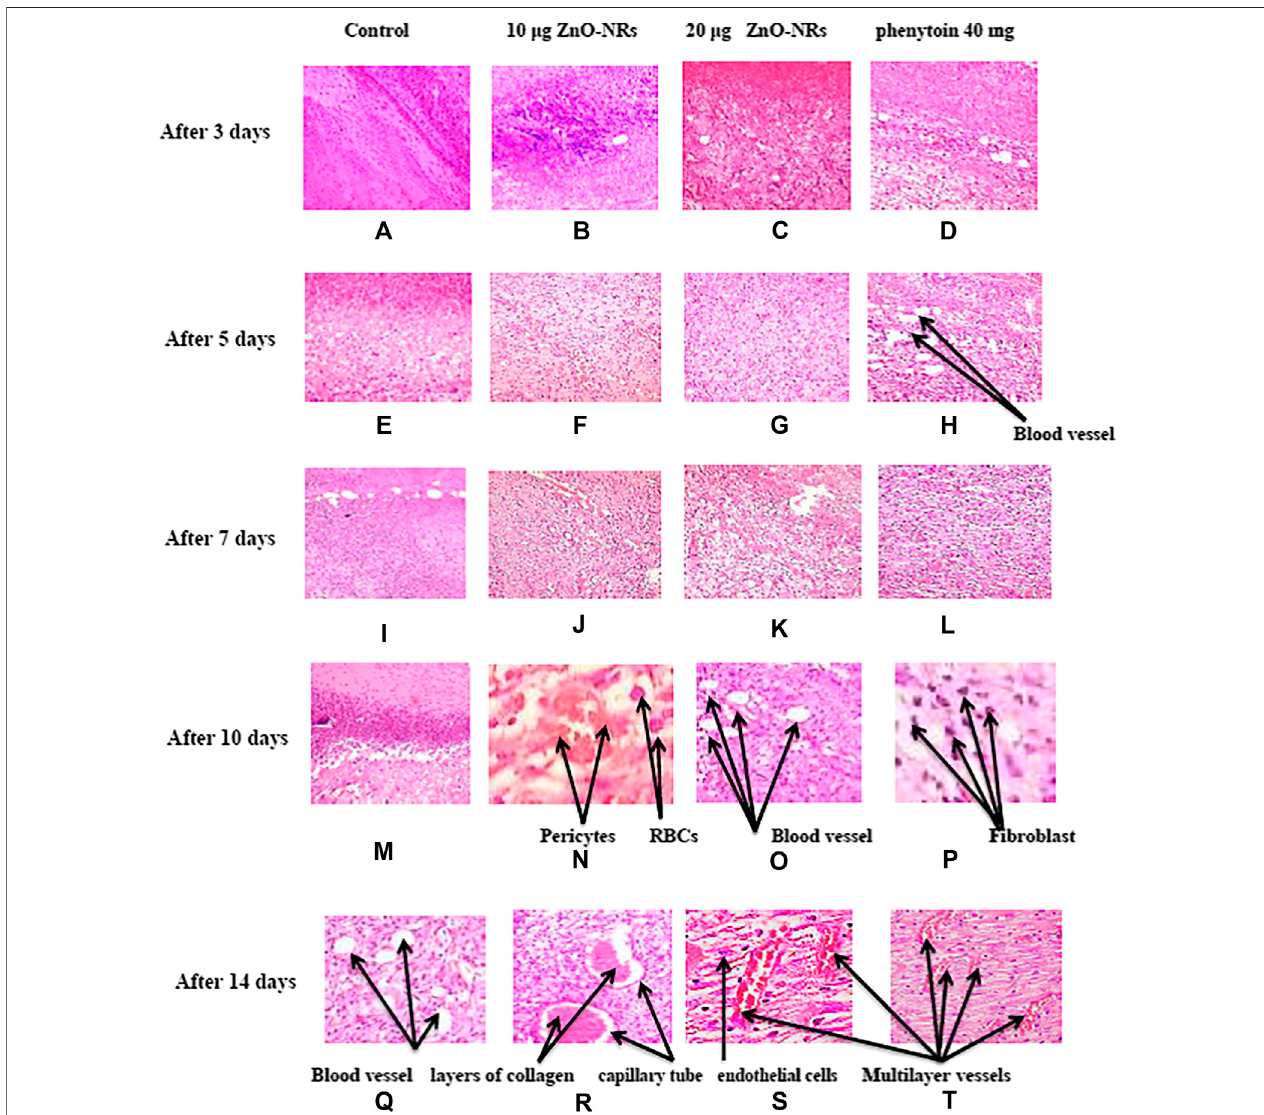
FIGURE14| HistopathologypatternofwoundhealingaftertreatmentwithZnOnanorods(ZnO-NRs),phenytoincomparedwithcontrol(non-treated). (A) Negative control (non-treated) after 3 days. (B) Wound healing after treatment with 10 μ g/ml of ZnO nanorods (ZnO-NRs) after 3 days. (C) Wound healing after treatment with 20 μ g/ml of ZnO nanorods (ZnO-NRs) after 3 days. (D) Wound healing after treatment with phenytoin as positive control after 3 days. (E) Negative control (non-treated) after 5 days. (F) Wound healing after treatment with 10 μ g/ml of ZnO nanorods (ZnO-NRs) after 5 days. (G) Wound healing after treatment with 20 μ g/ml of ZnO nanorods (ZnO-NRs) after 5 days. (H) Wound healing after treatment with phenytoin as positive control after 5 days. (I) Negative control (non-treated) after 7 days. ( J) Wound healing after treatment with 10 μ g/ml of ZnO nanorods (ZnO-NRs) after 7 days. (K) Wound healing after treatment with 20 μ g/ml of ZnO nanorods (ZnO-NRs) after 7 days. (L) Wound healingafter treatment with phenytoin as positive control after 7 days. (M) Negative control (non-treated) after 10 days. (N) Wound healing after treatment with 10 μ g/ml of ZnO nanorods (ZnO-NRs) after 10 days. (O) Wound healing after treatment with 20 μ g/ml of ZnO nanorods (ZnO-NRs) after 10 days. (P) Wound healing after treatment with phenytoin as positive control after 10 days. (Q) Negative control (non-treated) after 14 days. (R) Wound healing after treatment with 10 μ g/mlofZnOnanorods(ZnO-NRs)after14 days. (S) Woundhealingaftertreatmentwith20 μ g/mlofZnOnanorods(ZnO-NRs)after14 days. (T) Woundhealingafter treatment with phenytoin as positive control after 14